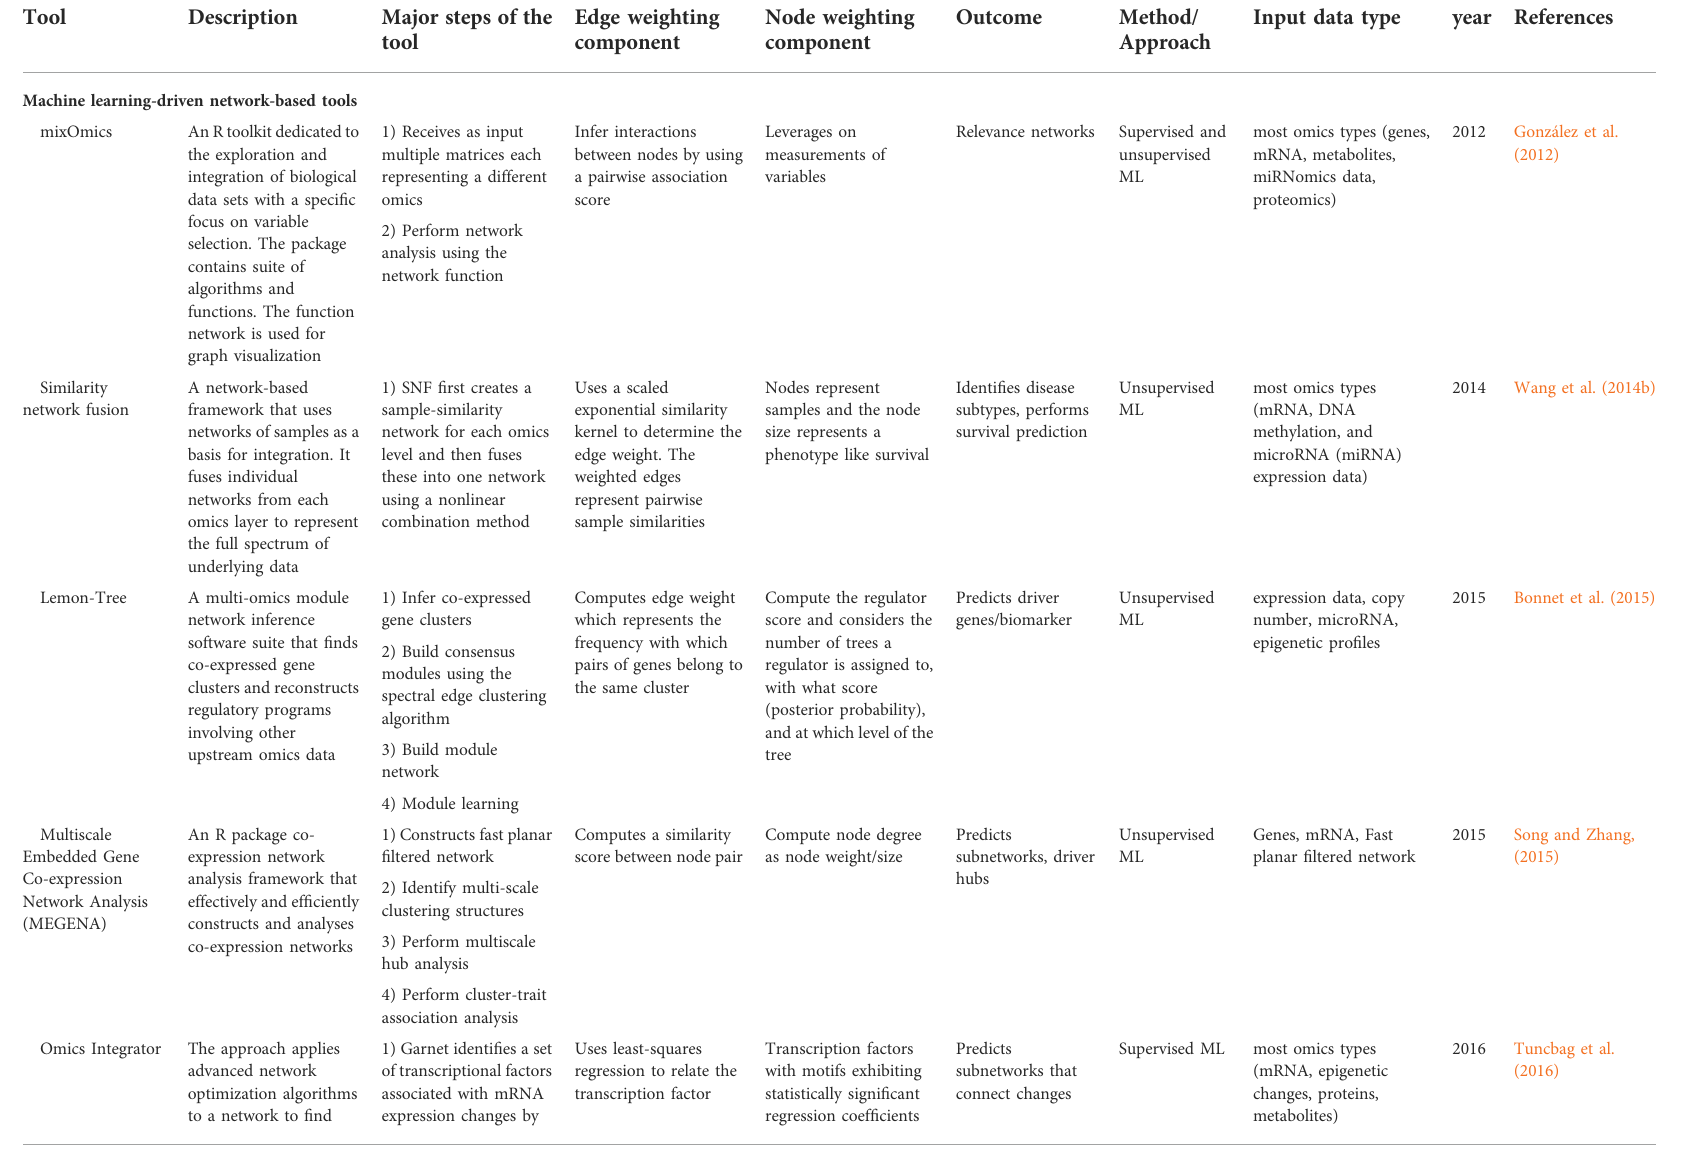
TABLE 1 Network-based multi-omics integrative tools for predicting biomarkers, crosstalk, disease subtypes, and subnetworks/enriched modules.